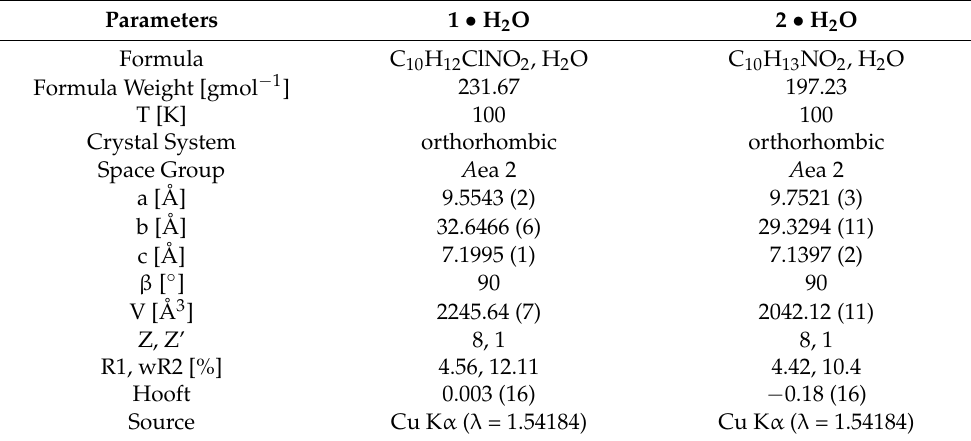
Table 1. Crystallographic data obtained by SC-XRD measurements of 1 • H 2 O and 2 • H 2 O . Parameters